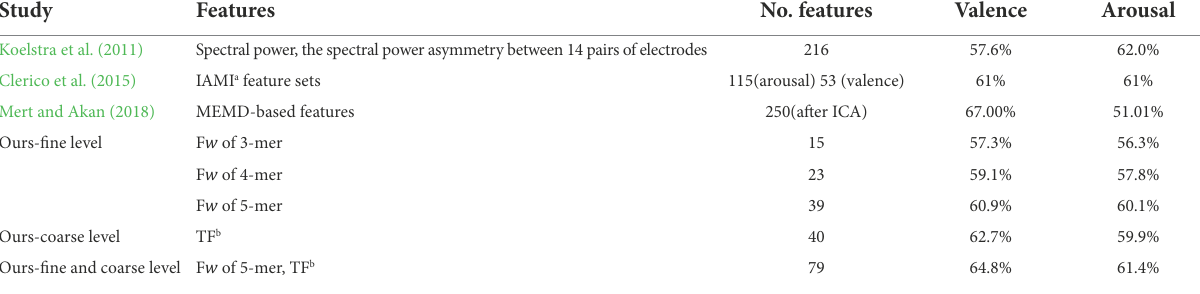
TABLE 1 The classification accuracies of different feature sets on DEAP